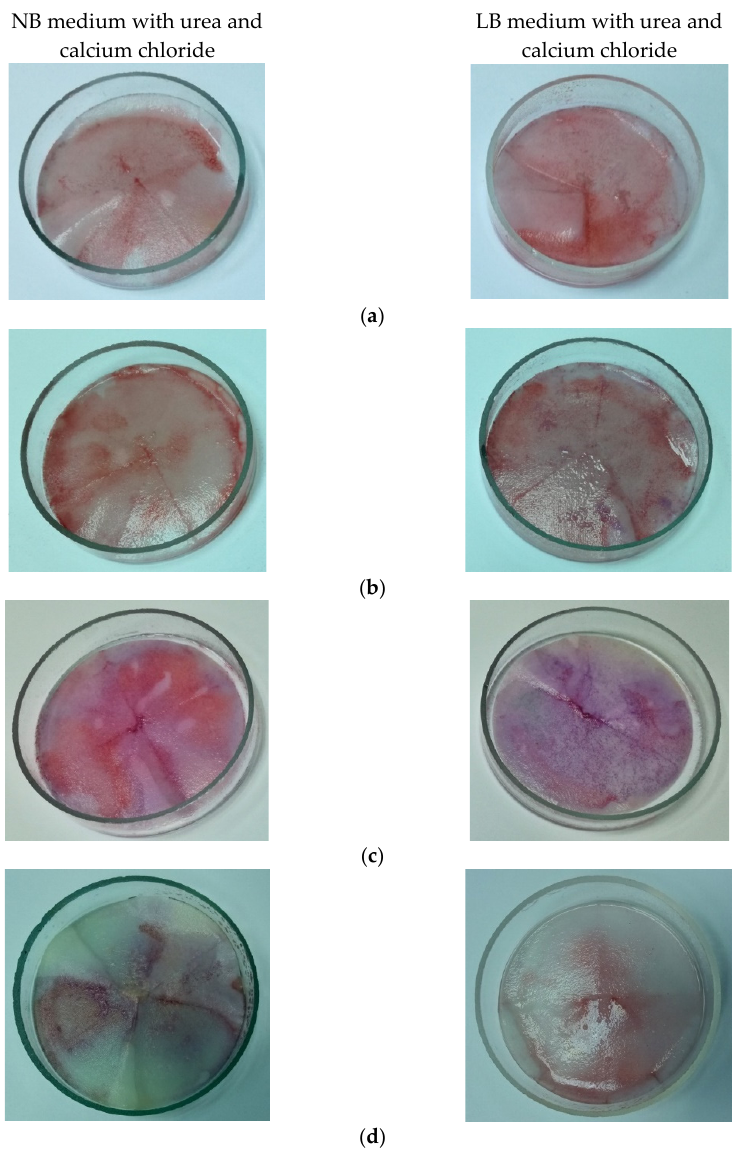
Figure 1. Alizarin colorimetric assay for testing carbonatogenesis ability of bacterial strains: ( a ) Bacillus amyloliquefaciens ; ( b ) Bacillus licheniformis ; ( c ) Bacillus subtilis ; ( d ) Psuedomonas putida .